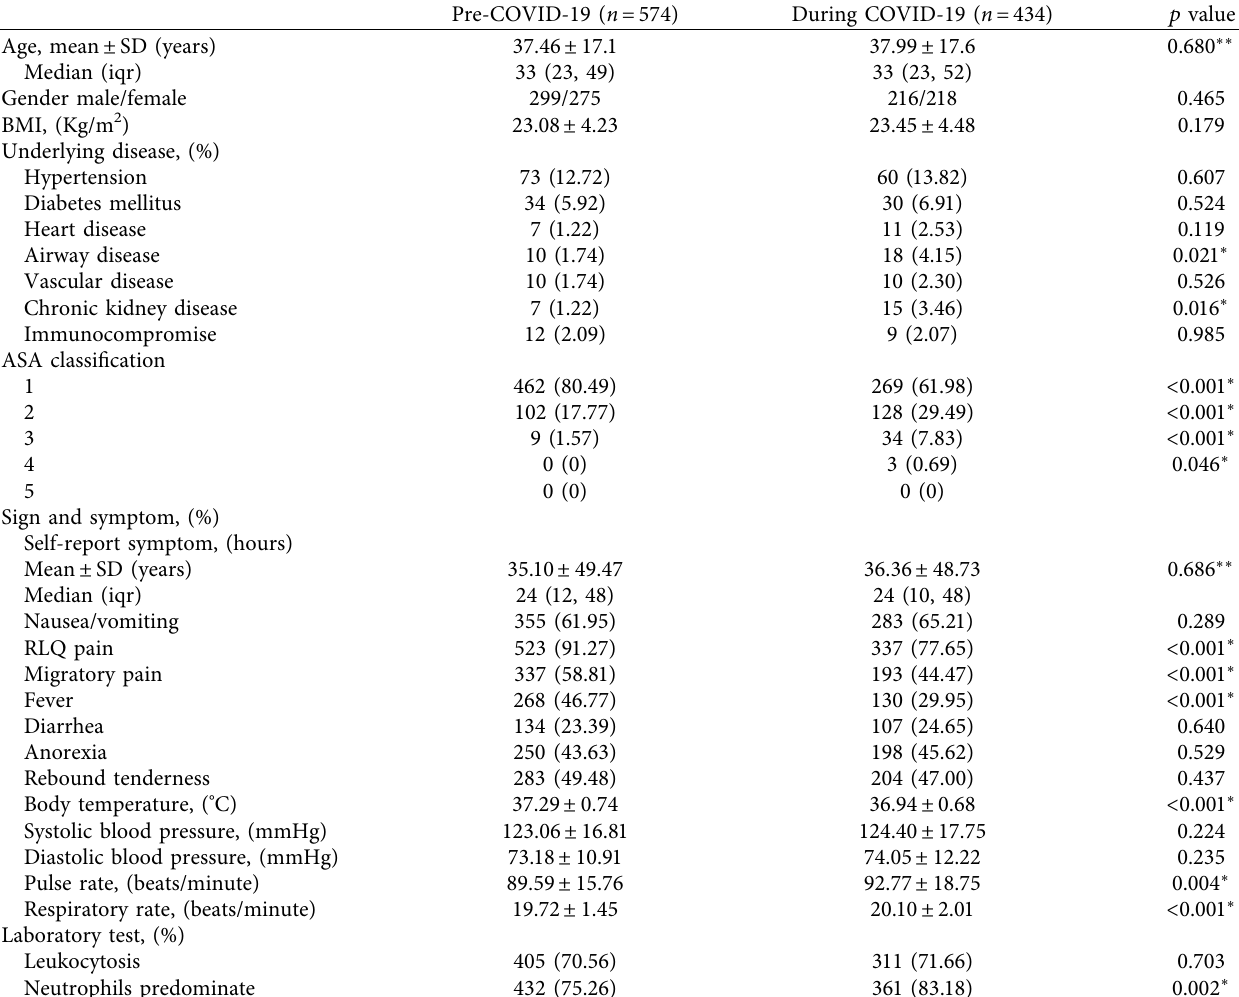
Table 1: Demographic data of adult patients with acute